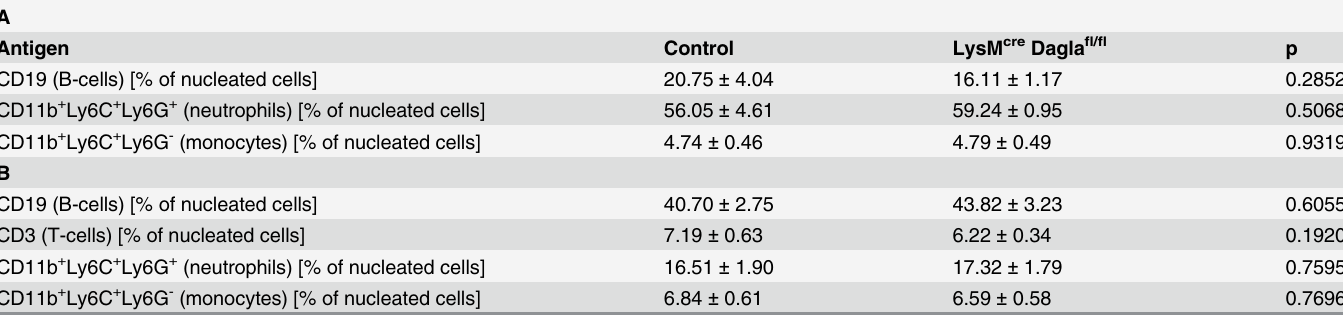
Table 2. Flow cytometry analyses of bone marrow and peripheral